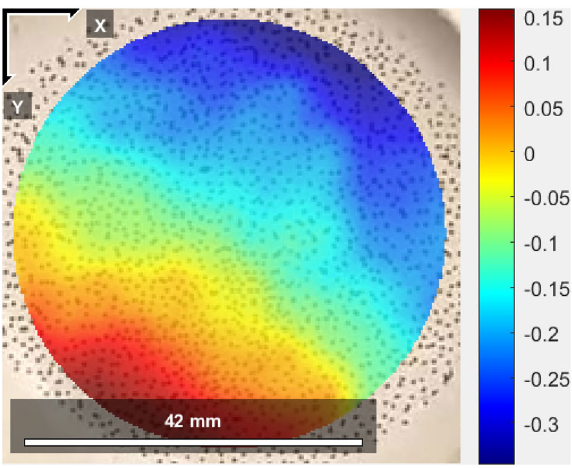
Figure 8. Strain nephogram obtained by DIC method.